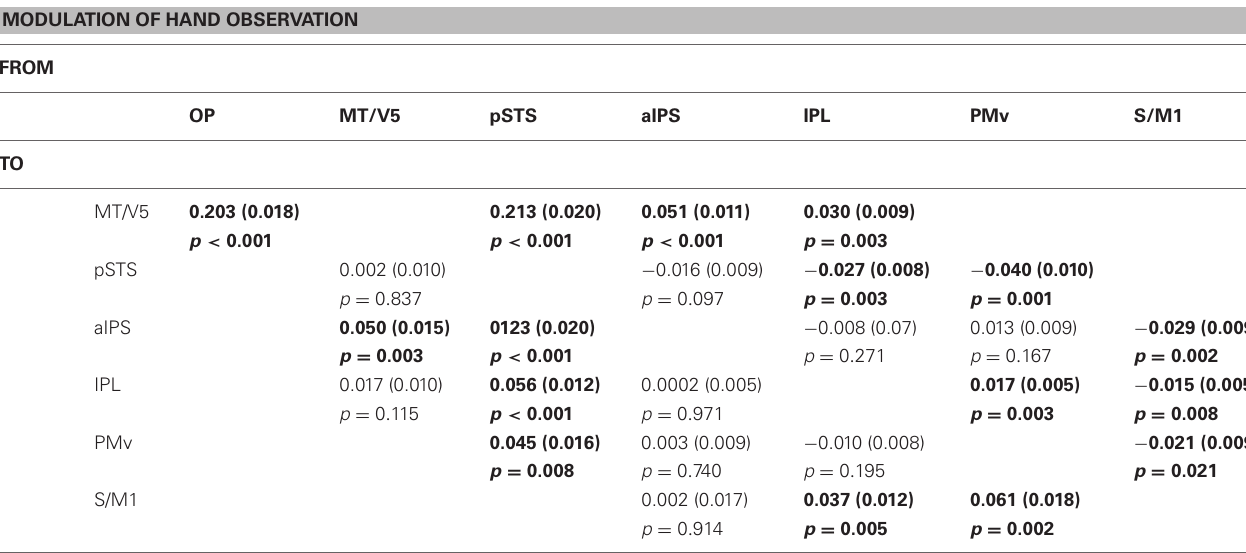
Table 9 | Results of one-sample t -test for coupling parameters of Hand observation modulation. MODULATION OF HAND